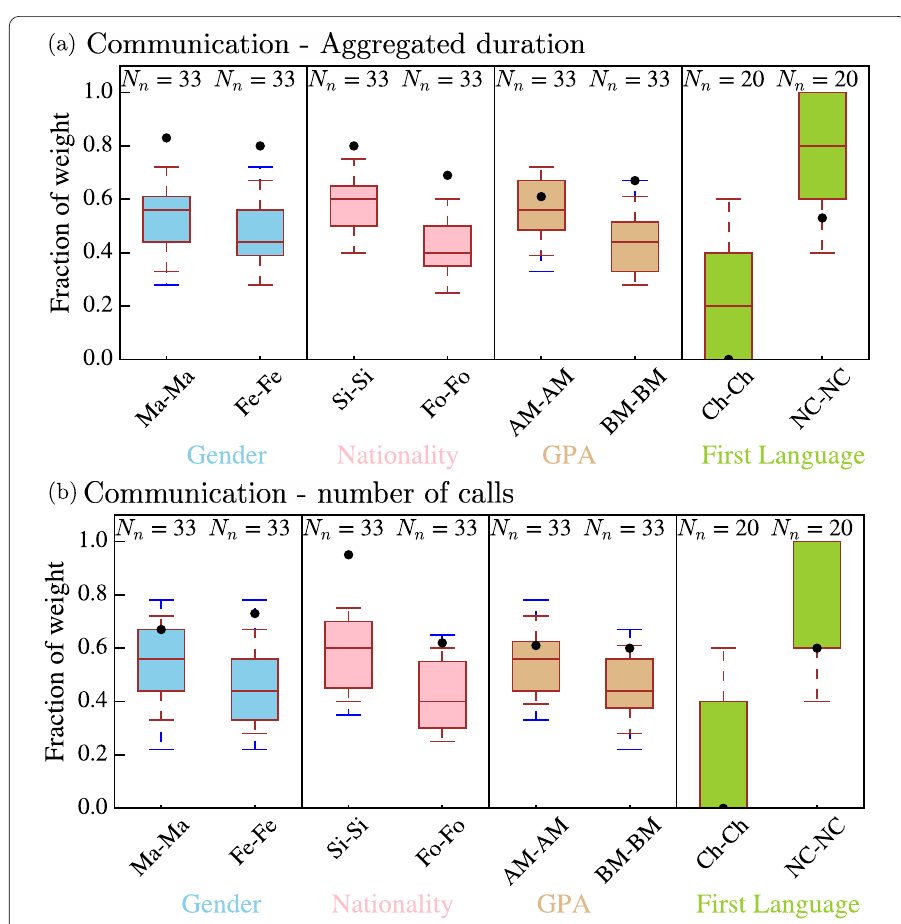
Figure 11 Homophily in social preference—yearly-aggregated communication network. Ma: Male; Fe: Female; Si: Singaporean; Fo: Foreigner; AM: Above Median; BM: Below Median; Ch: Chinese; NC: Non-Chinese. Data (black dots) are compared with the distribution (boxplots) obtained for a null model in which attributes are reshuffled among nodes. Boxplot: Whiskers—5th, 10th and 90th, 95th percentiles; box—25th and 75th